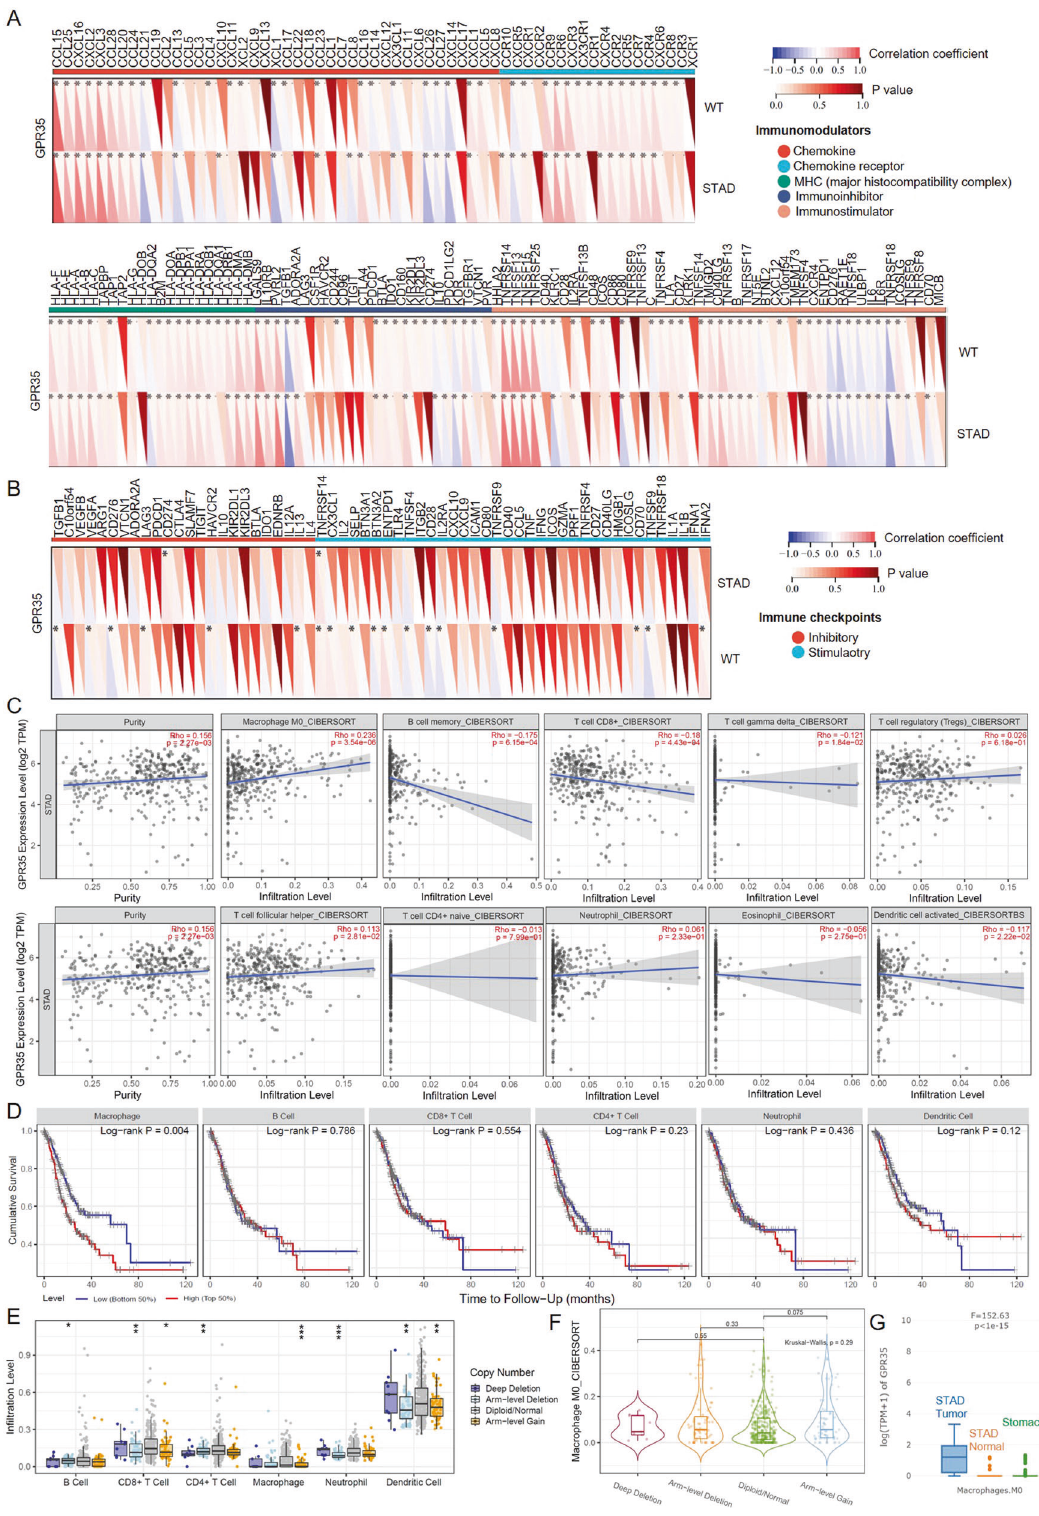
Fig. 6 GPR35 links in fi ltration of immune cells in GC tumors. A , B Correlation coef fi cient between signature genes (immunomodulators ( A ) and immune checkpoints ( B )) and GPR35 expression level. C Relation between GPR35 expression level and in fi ltration level of various immune cells. D Cumulative survival for different in fi ltration levels of immune cells in GC patients. E The in fi ltration level of various immune cells under different copy numbers of GPR35 in GC. *, **, and *** represents p < 0.05, p < 0.01, and p < 0.001, respectively. F The in fi ltration level of macrophage M0 under different copy numbers of GPR35 in GC. P values were calculated with the Kruskal – Wallis test. G GPR35 expression level in stomach normal tissues, tumor-adjacent tissues, and STAD (GC) tumors. P value was calculated with the F -test.